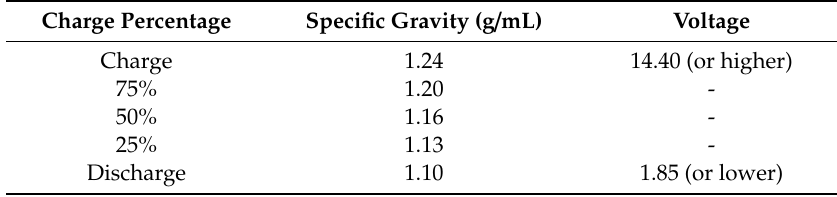
Table 1. Expected variance of percentage of charge of a battery based on its specific gravity and output